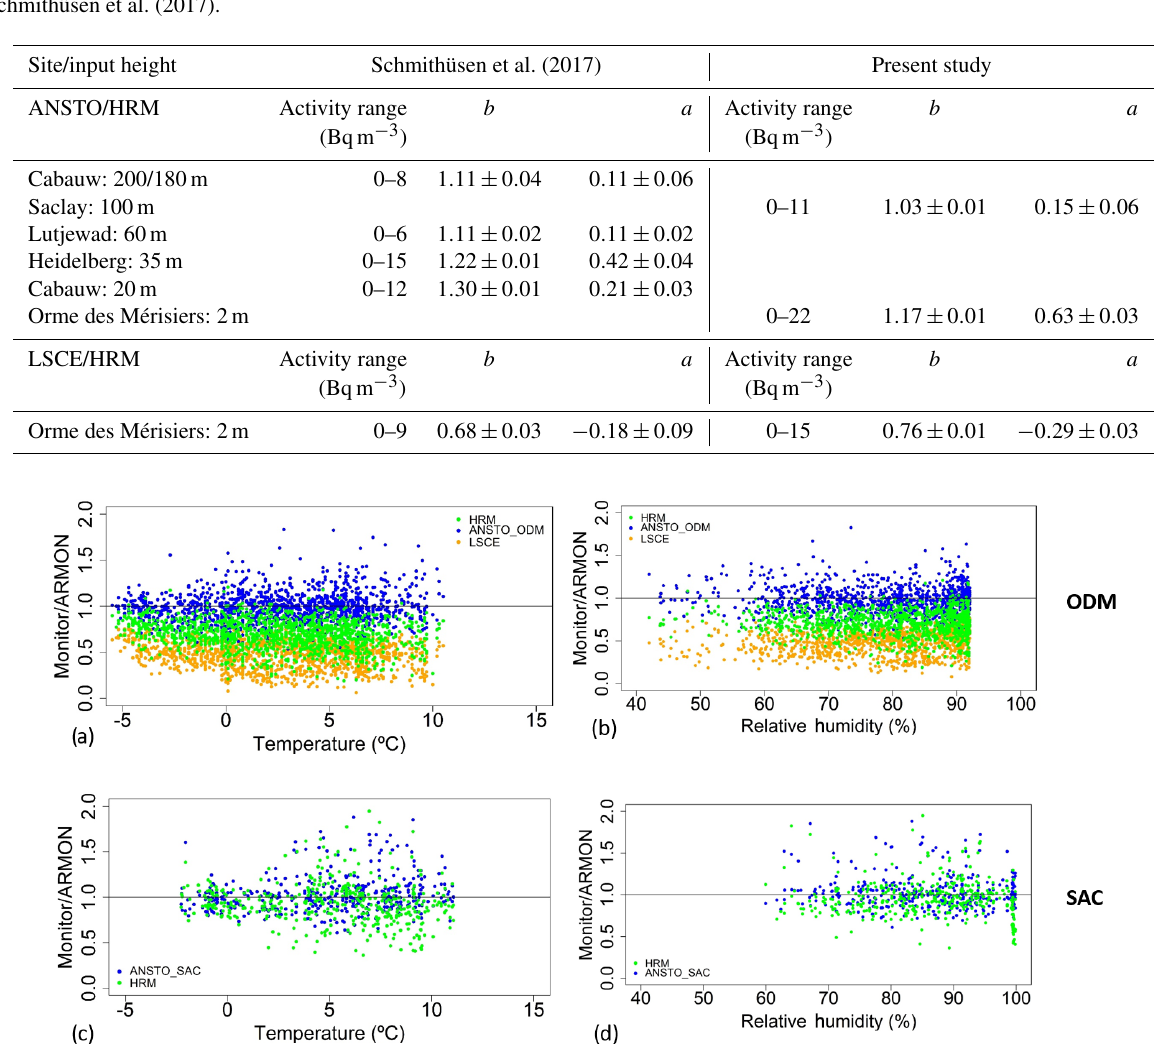
Figure 4. Hourly atmospheric 222 Rn or 214 Po activity concentration obtained by the HRM, LSCE, and ANSTO monitors divided by the 222 Rn activity concentration measured by the ARMON detector as a function of the hourly measured atmospheric temperature and relative humidity at ODM (a, b) and at SAC (c, d)